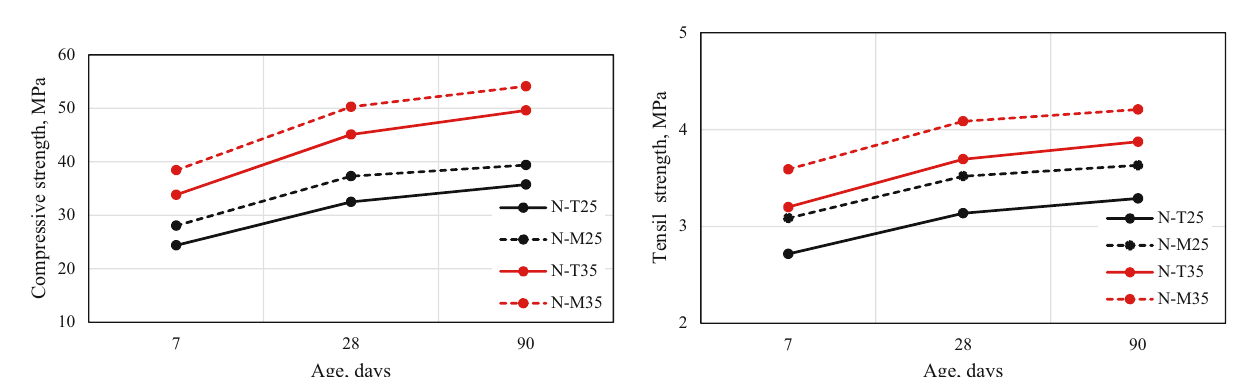
Figure 5: Tensile strength results for normal mixes using tap and magnetized water.